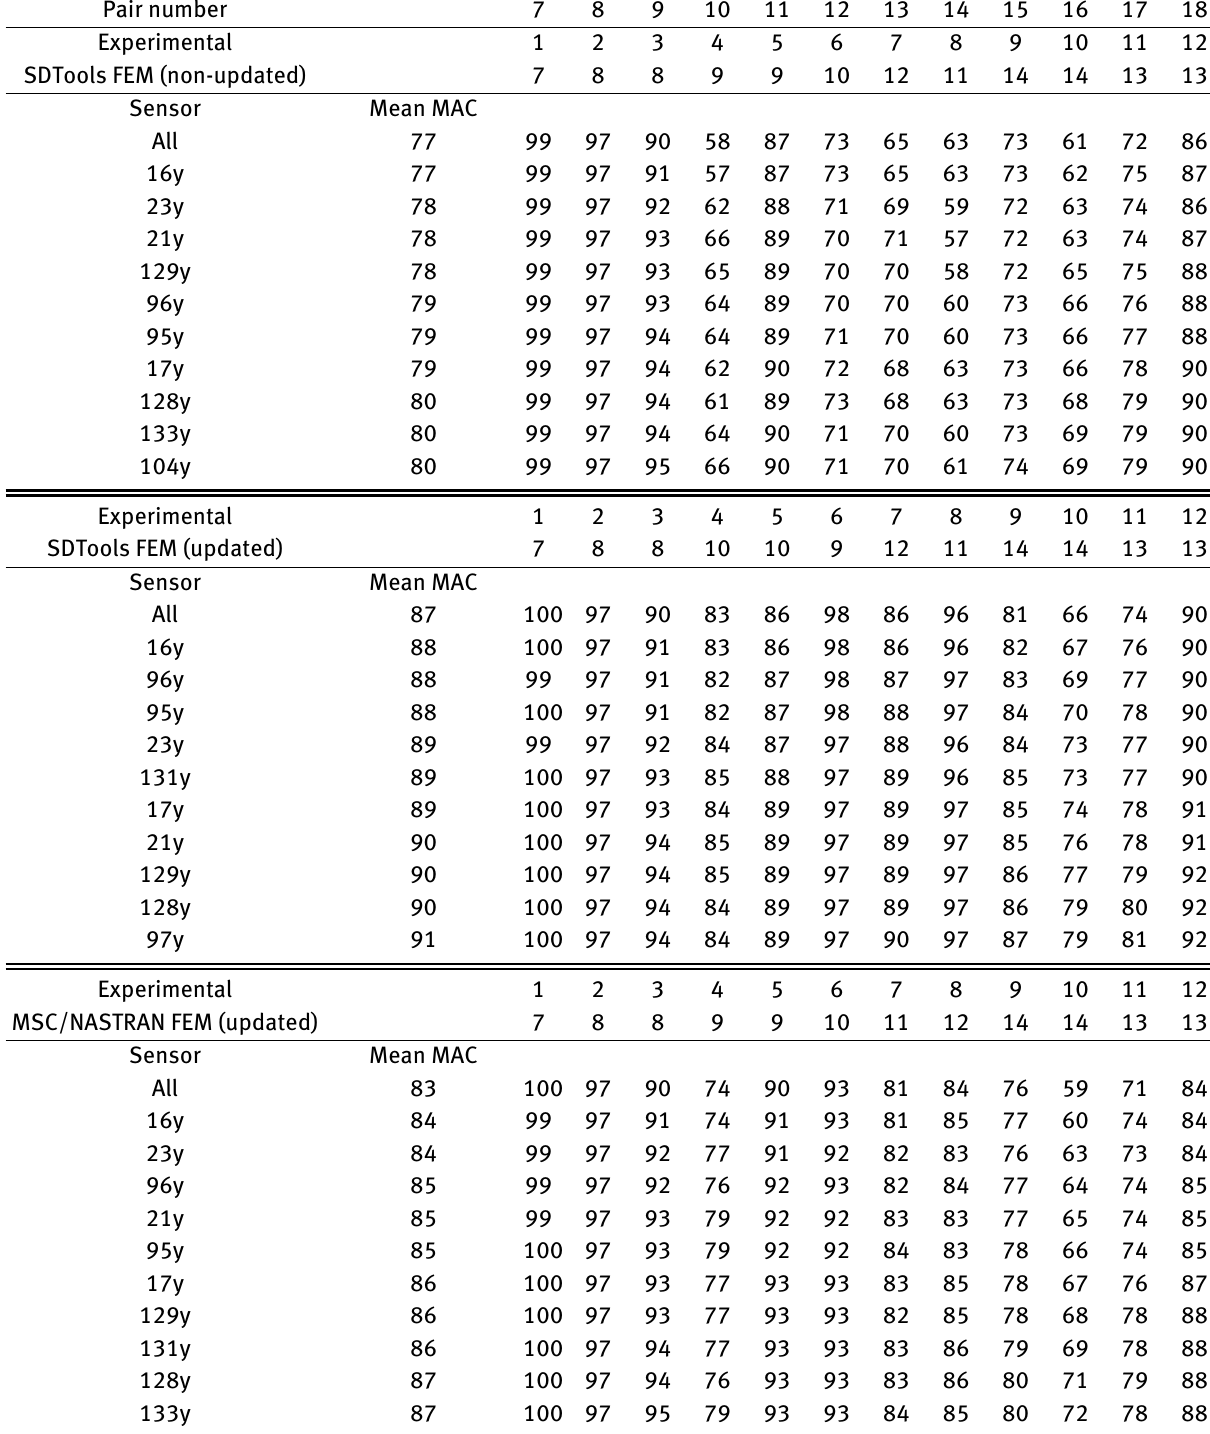
Table 2: MACco results - Full models versus experimental